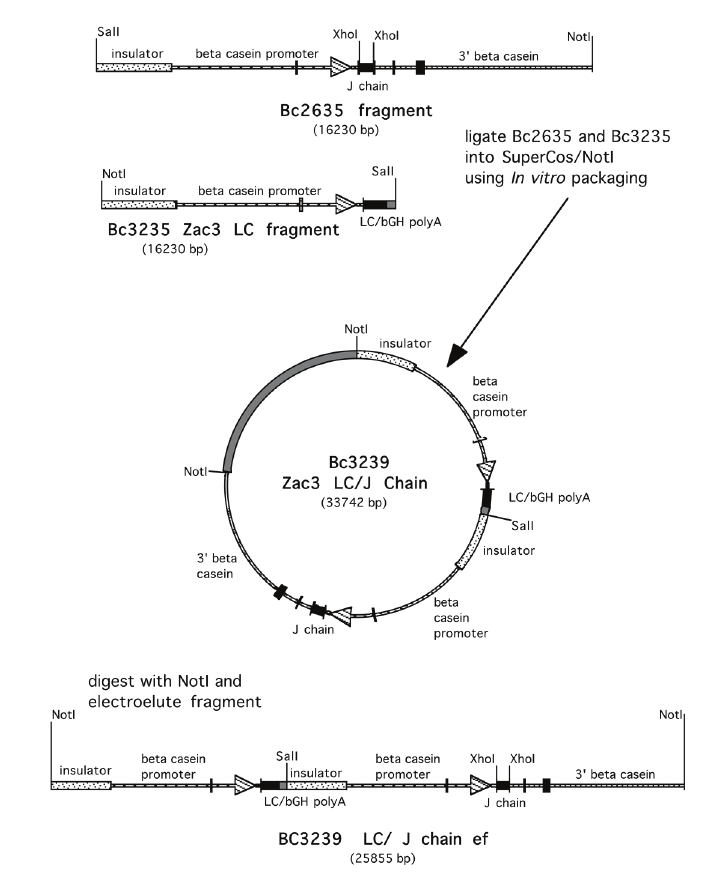
Supplementary Figure 4. Construction of BC3239 IgA LC/J Chain. To aid in micro-injection, the con- structs carrying the LC and J chain were linked. The NotI-SalI fragment of BC3235 was isolated from the SuperCos bacterial vector. The SalI-NotI fragment containing the J chain was also isolated from BC2635. These 2 fragments were ligated together cloned into SuperCos using the lambda IVP system. The resulting plasmid, BC3239 carries both constructs as a 26 kb NotI